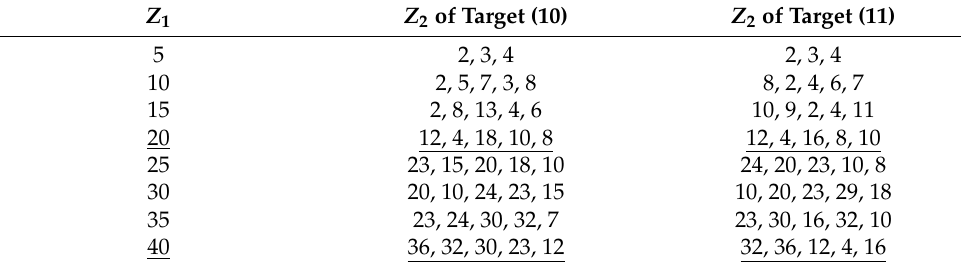
Table 6. Low-noise pole-slot numbers scheme for p = 2.